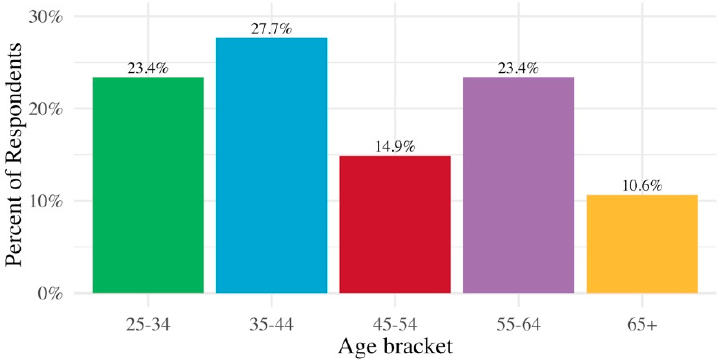
Figure A3. Age of participants. Total question respondents: 51 .